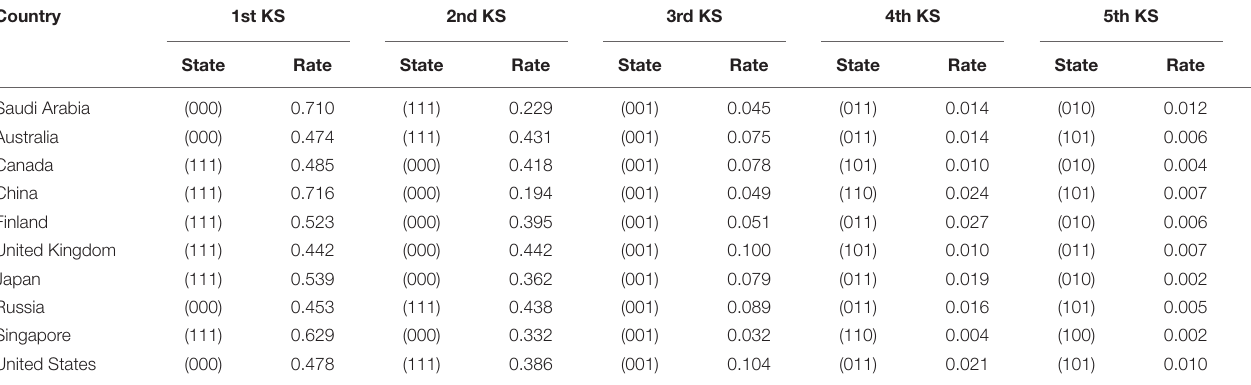
TABLE 6 | Knowledge states of the top five process attributes in 10 countries. Country